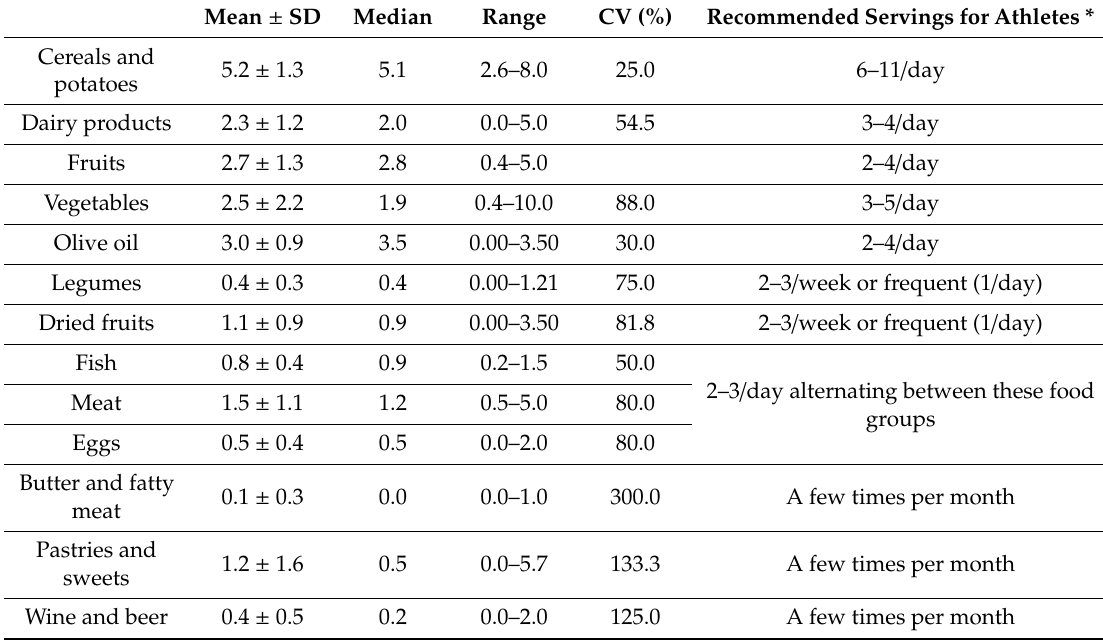
Table 2. Number of servings of di ff erent foods consumed daily by marathon runners and the dietary recommendations of reference for athletes ( n =